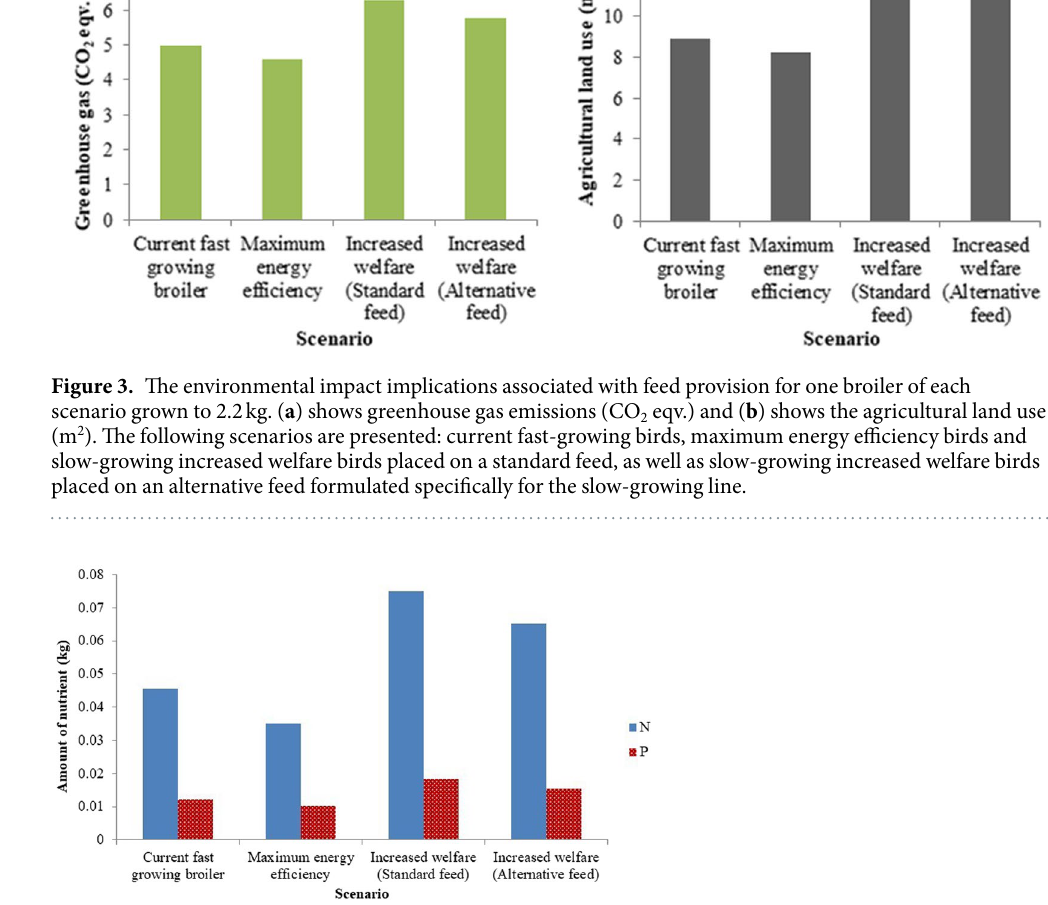
Figure 4. The nutrients, nitrogen (N) and phosphorus (P), that are expected to be excreted when one broiler is raised to 2.2 kg slaughter weight. The following scenarios are presented: current fast-growing birds, maximum energy efficiency birds and slow-growing increased welfare birds placed on a standard feed, as well as slow- growing increased welfare birds placed on an alternative feed formulated specifically for the slow-growing